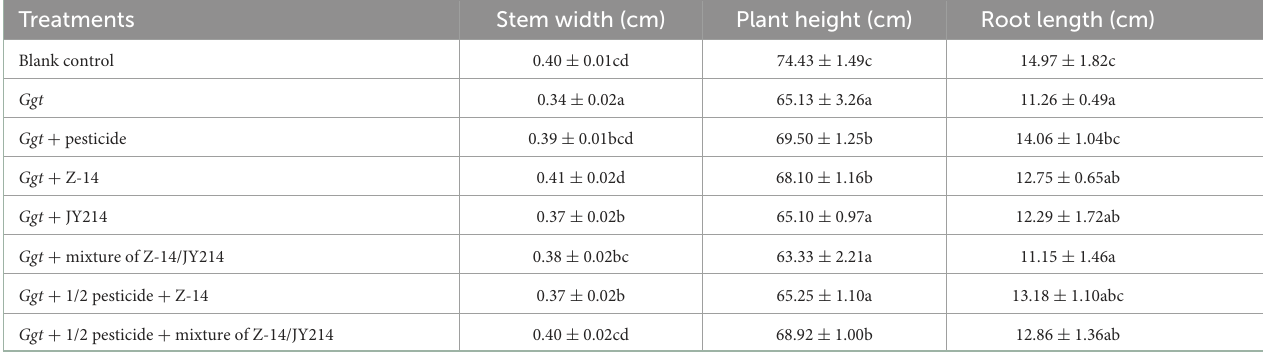
TABLE 6 Effects of pesticide, Z-14, JY214, and their combinations on root length, root fresh weight, and aboveground weight of Ggt -infected wheat in the field experiments. Treatments